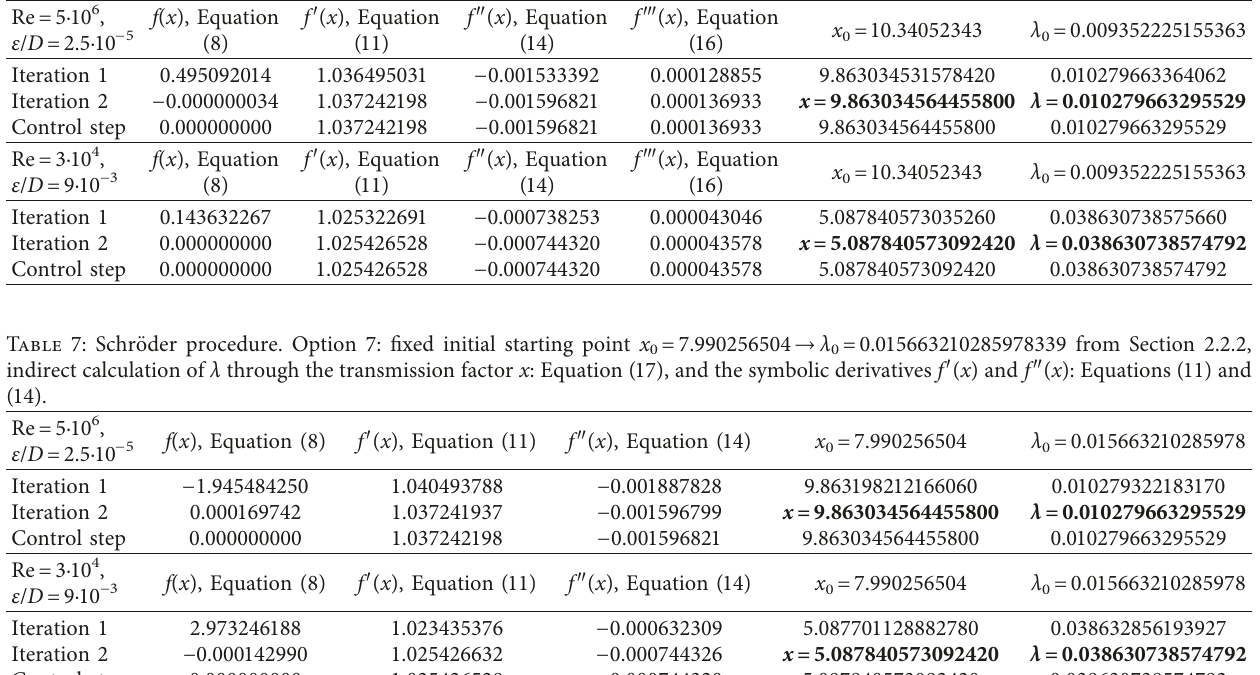
Table 6: Third-order Householder’s procedure. Option 6: starting point x of λ through the transmission factor x : Equation (15), and the symbolic derivatives f ′ ( x ), f ″ ( x ), and f ‴ ( x ): Equations (11), (14), and (16). Re � 5 · 10 6 ,